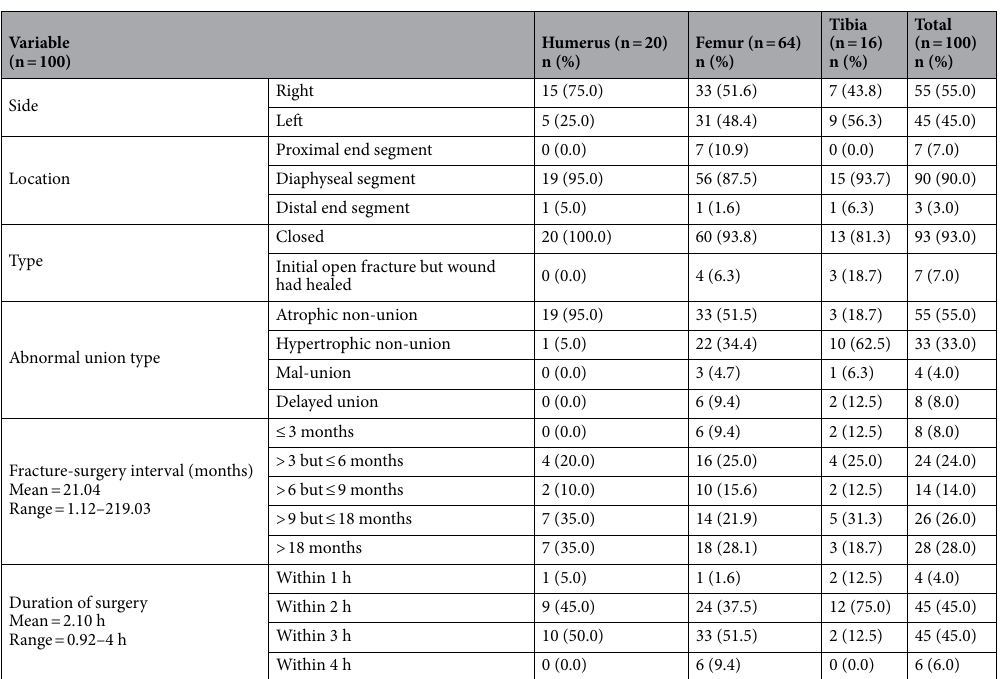
Table 3. Fracture characteristics and treatment details.